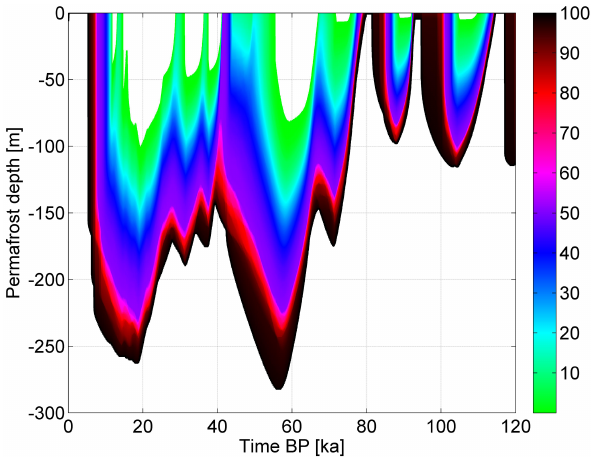
Figure 7. Simulated depth for different freezing states along a N–S transect from polygon centre FRP in the north to LBH in the south. See Fig. 1 for location of the profile.